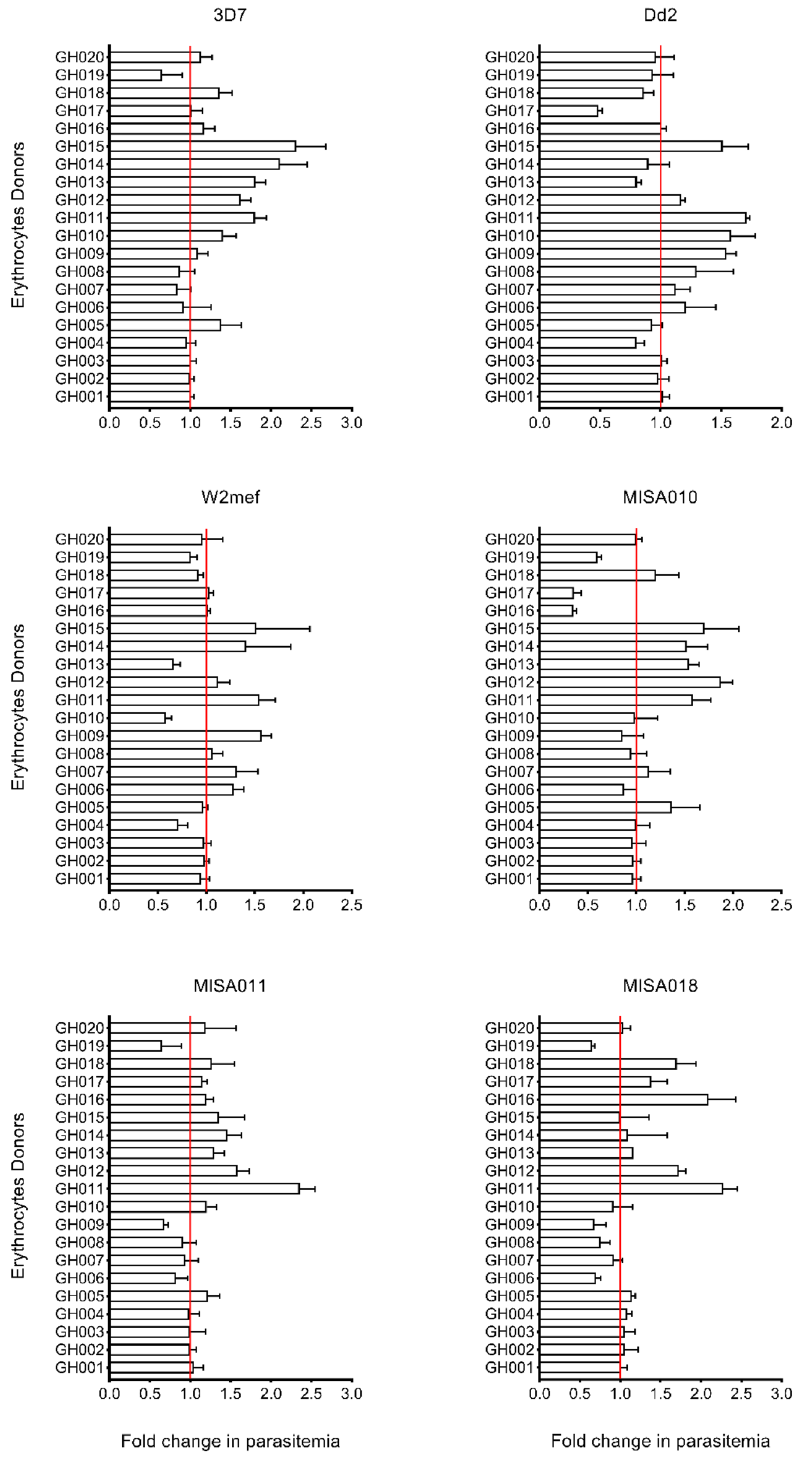
Figure 1. Bar graphs showing fold changes in parasitemia in untreated donor erythrocytes relative to the reference sample. Parasitemia from individual donors were normalised using a reference erythrocyte sample, which was used for routine parasite culturing and included in all assays. Fold-change in parasitemia was calculated as follow ParSMean/ParCMean, where ParSMean is the mean of uncorrected parasitemia of the sample and ParCMean the mean of parasitemia of the control sample. One-way ANOVA was used to compare the statistical analysis following normality test. Represented are summary data (mean + SD) from at least two independent experiments conducted in